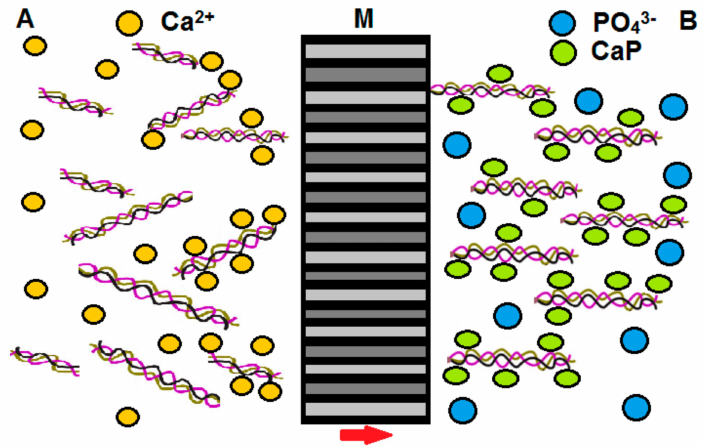
Figure 2. Experimental setup based on a nanoporous membrane (M) for the formation of mineralised COL fibrils as proposed by Maas et al. [89]. ( A ) Solution containing Ca 2 + cations (yellow) and monomolecular tropocollagen. ( B ) Solution containing PO 43 − anions (blue) and the formation of amorphous CaP (green) together with the self-assembly of collagen fibrils in the direction of the flow of the feed solution (red